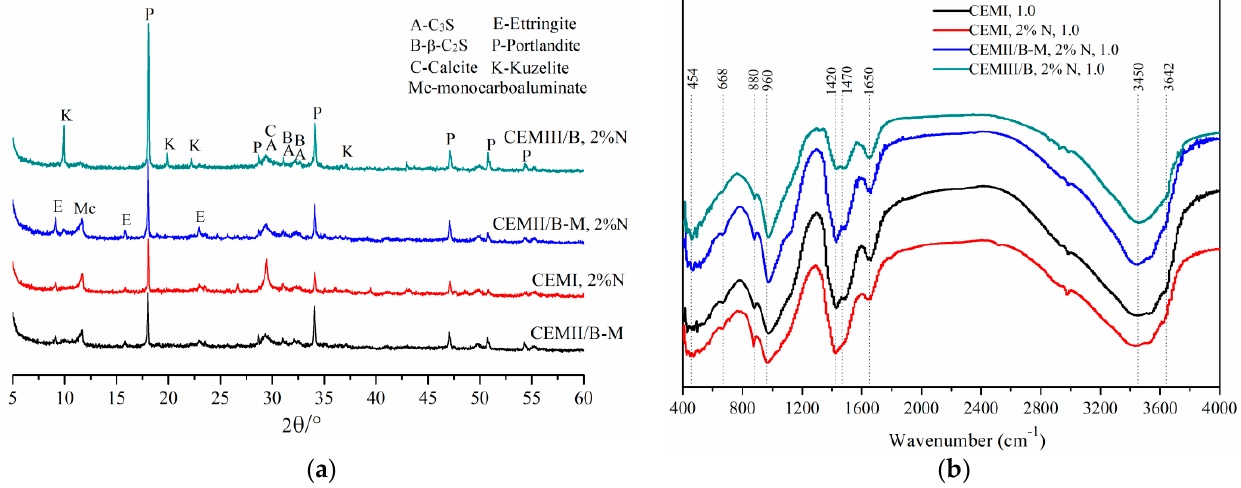
Figure 16. XRD and FTIR results of 28-day SMCG stone bodies at the W/S of 1.0. ( a ) XRD results; ( b ) FTIR results.